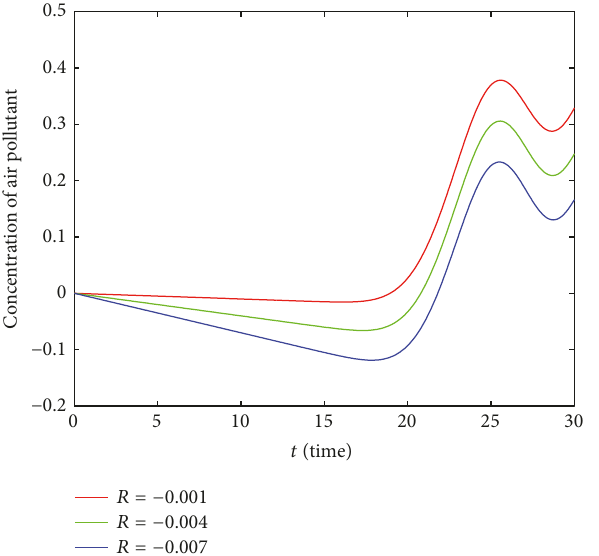
Figure 23: Compare the concentration of air pollutant at 𝑥 = 60 m , 𝑦 = 14 m , 𝑧 = 4 m of sinks in different time.